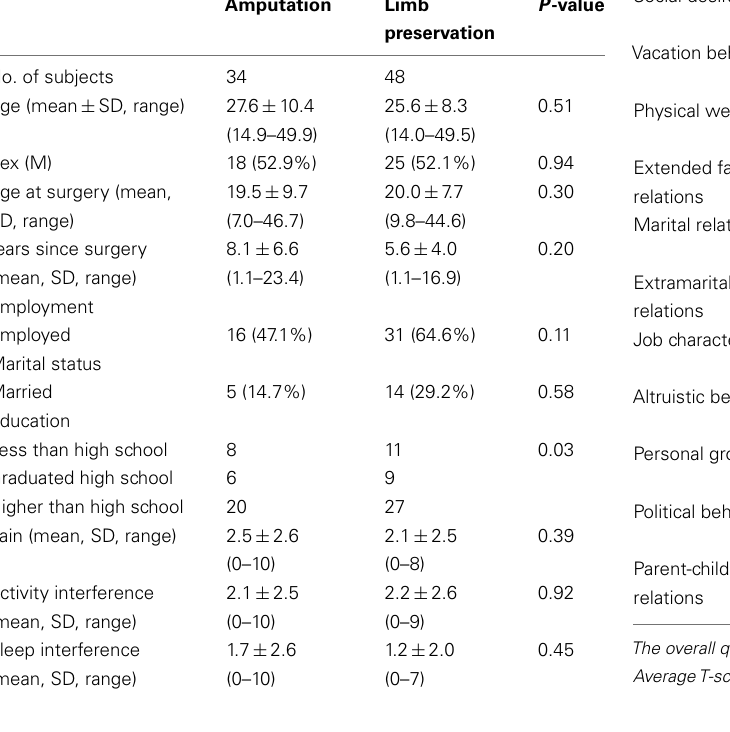
Table 1 | Characteristics of patients with lower extremity bone sarcoma.